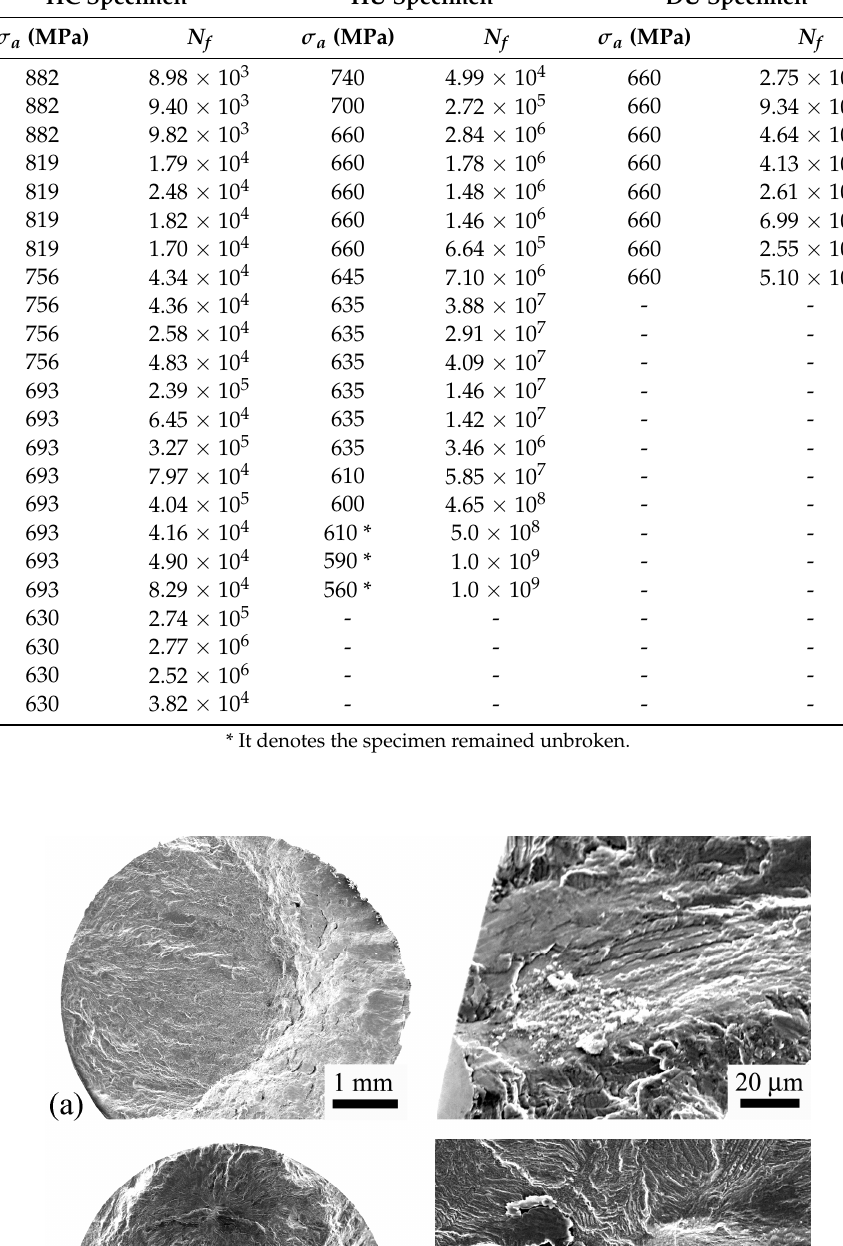
Figure 7. SEM observations of fracture surfaces for HU specimens. ( a ) Crack initiates from specimen surface, σ a = 635 MPa, N f = 2.91 × 10 7 ; ( b ) Crack initiates from the interior of specimen, σ a = 600 MPa, N f = 4.65 × 10 8 .